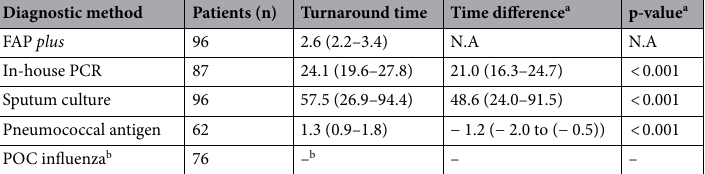
Table 2. Turnaround time for the BioFire FilmArray Pneumonia panel plus versus standard microbiological methods. Comparison of the turnaround time for different microbiological diagnostic methods used in this study. Numbers presented are median hours with IQR if not otherwise specified. P-values are calculated with Student’s paired t-test on logarithm-transformed times. FAP plus , Biomérieux BioFire FilmArray Pneumonia panel plus ; PCR, polymerase chain reaction; POC, point of care; N.A., not applicable; IQR, inter-quartile range. a Compared to the FAP plus. b Turnaround time was not recorded for the POC Influenza test (ID NOW). It was directly available in the ED, with an analysis time of approximately 15